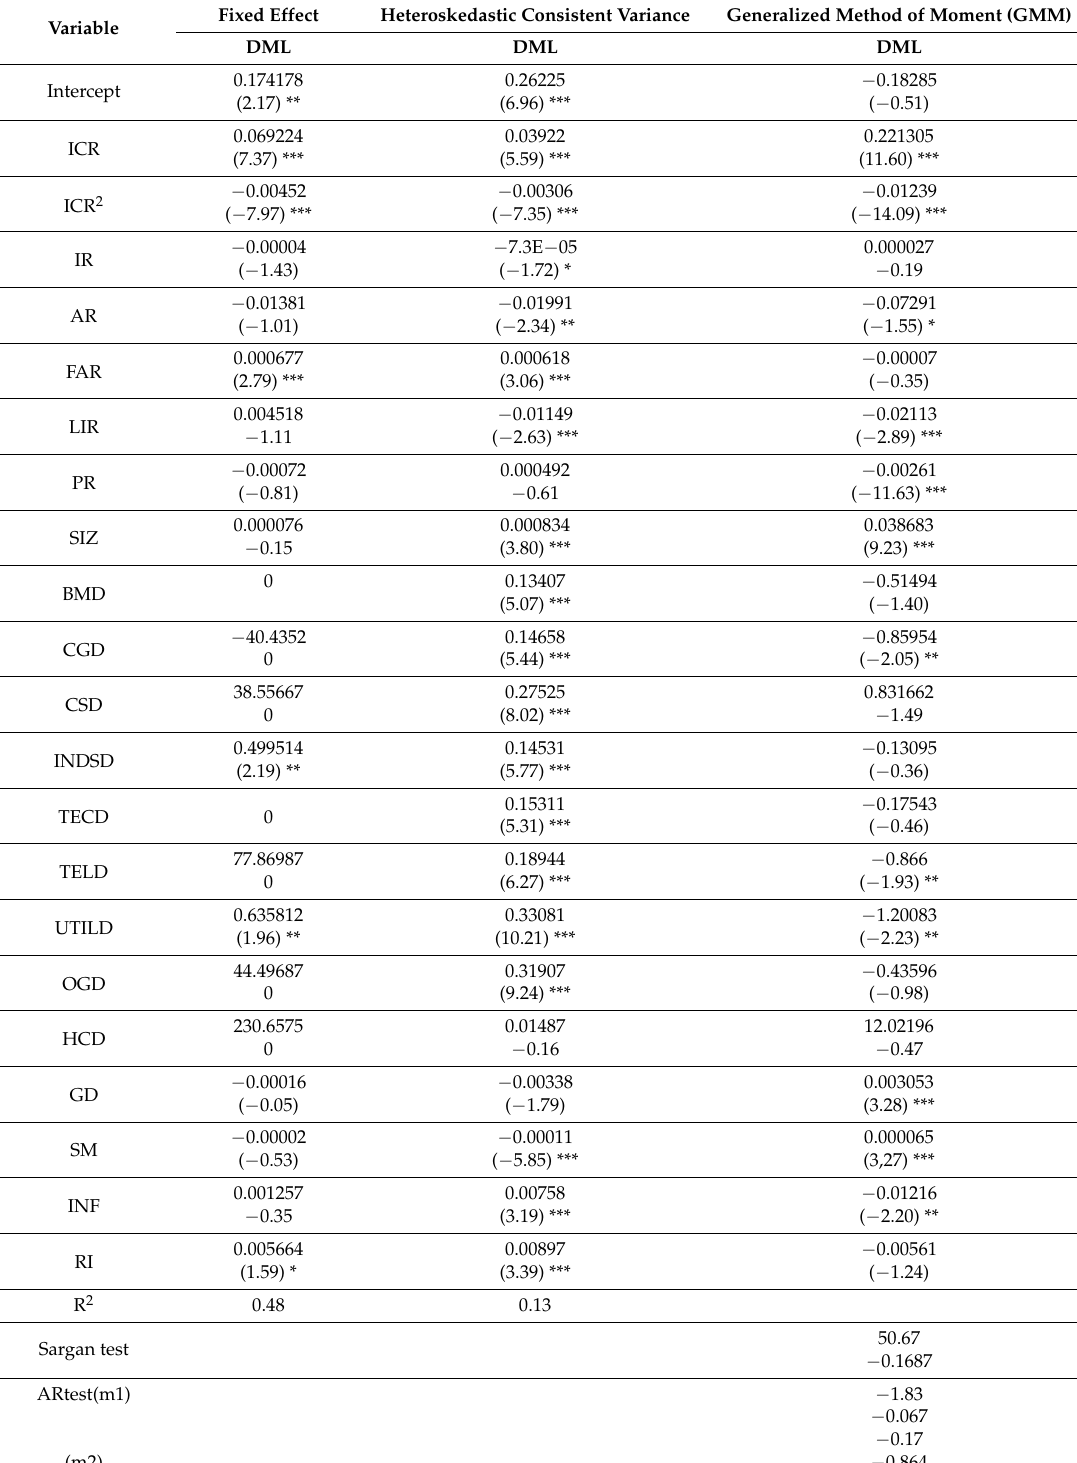
Table 6. Credit ratings and maturity structure of